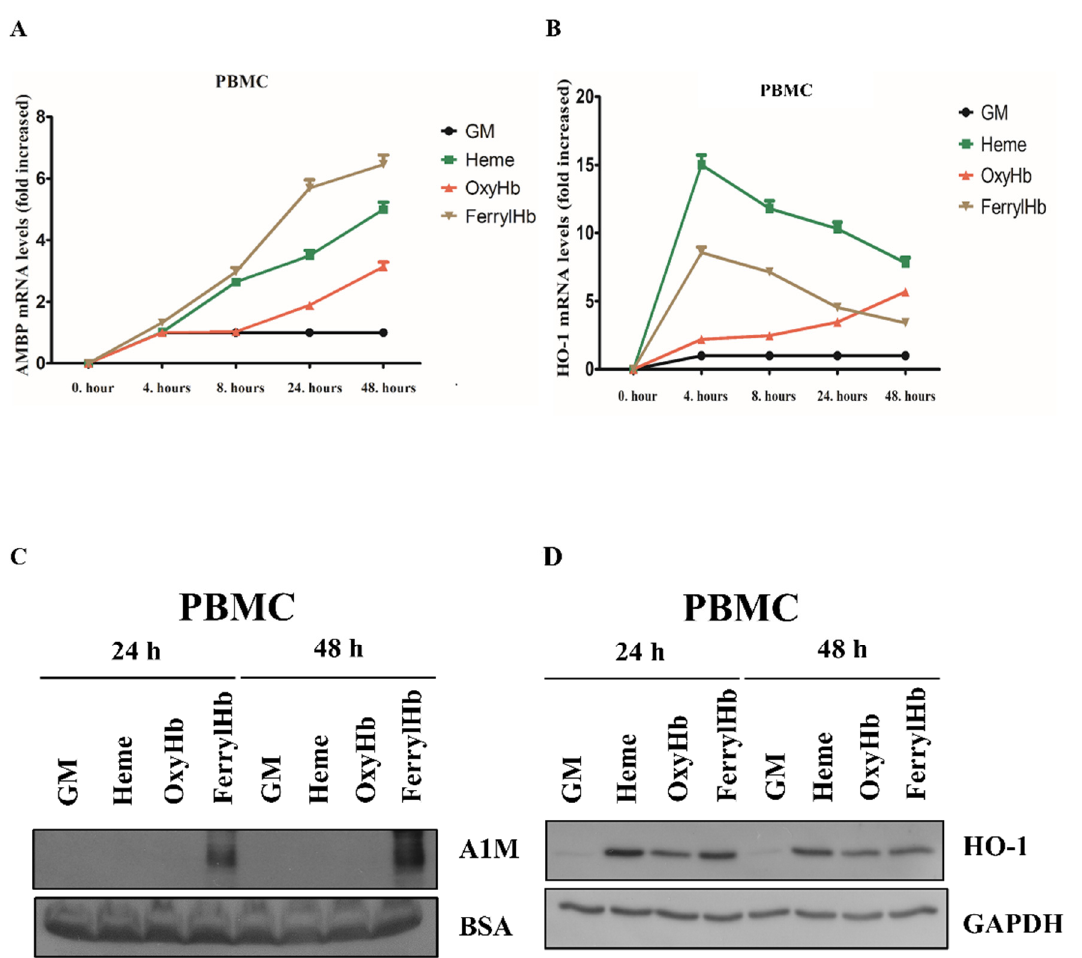
Figure 4. A1M expression is induced in human peripheral blood mononuclear cells (PBMCs). PBMCs were exposed to heme (10 µM), OxyHb (10 µM), or FerrylHb (10 µM) in the presence of 5% foetal calf serum. A1M ( A ) and HO-1 ( B ) mRNA expression was quantified by qPCR after 4, 8, 24 and 48 h. ( C ) Secreted A1M protein was detected by immunoblotting in cell culture supernatants, while HO-1 protein expression ( D ) was examined in cell lysates after 24 and 48 h. GM: growth medium, BSA: bovine serum albumin, GAPDH: glyceraldehyde 3-phosphate dehydrogenase.